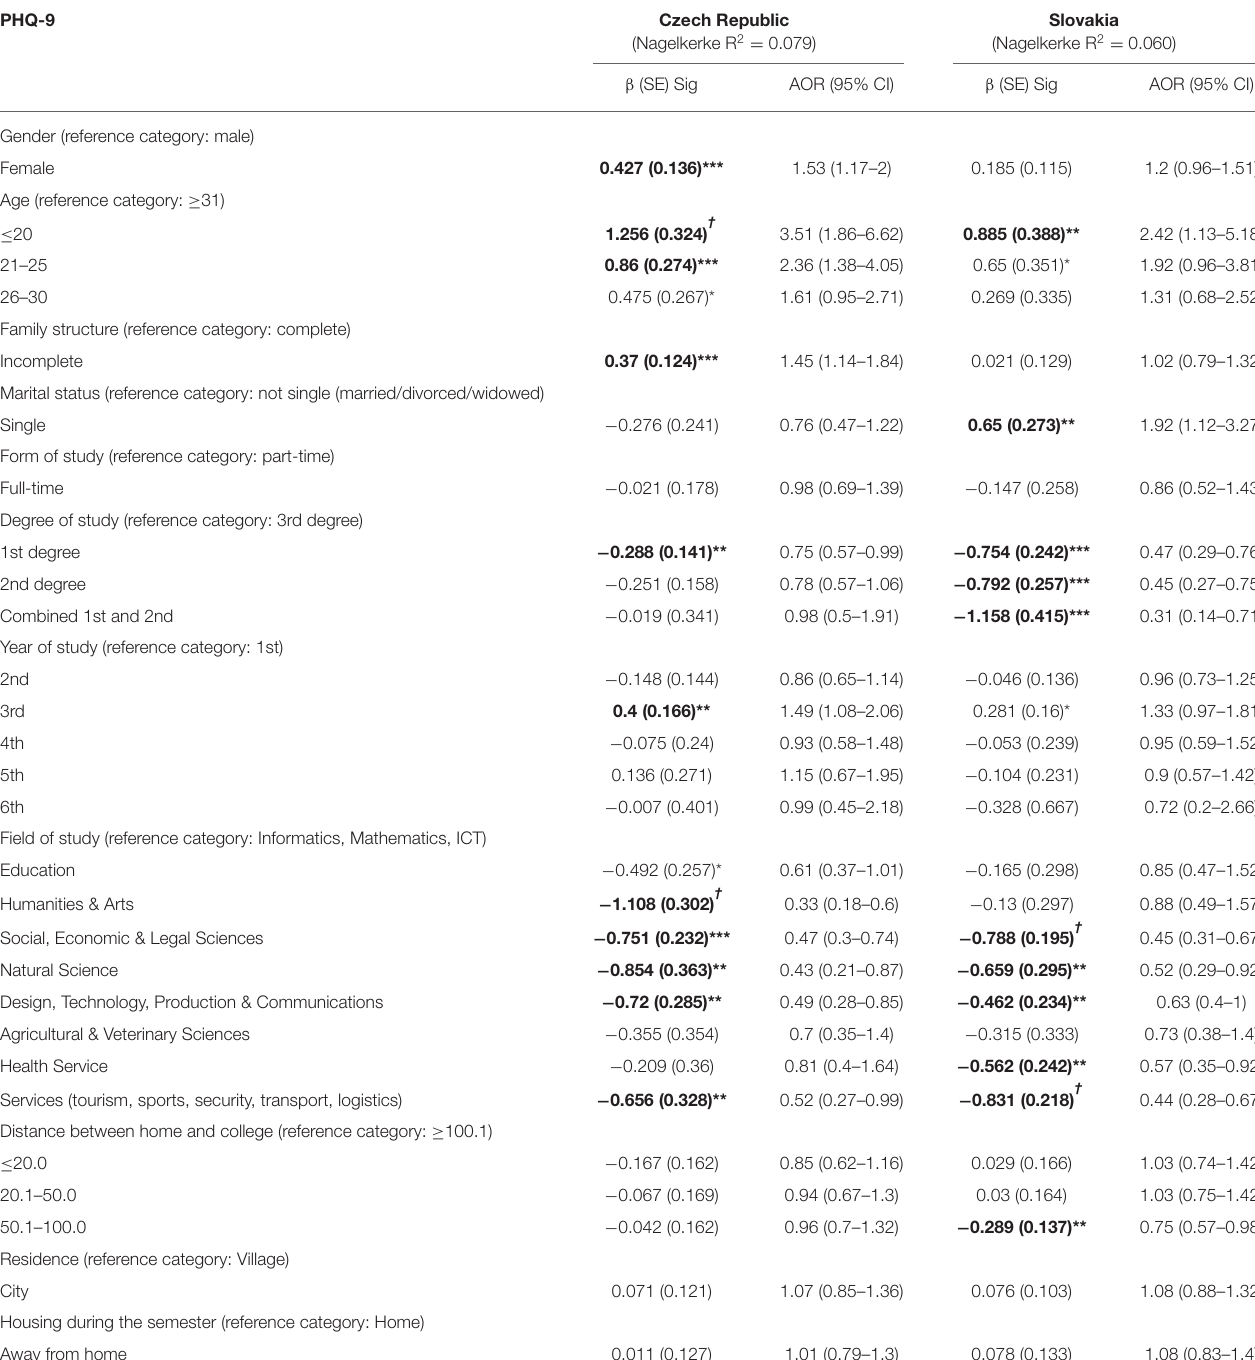
TABLE 5 | Logistic regression analysis with depression (PHQ-9) as a dependent variable.